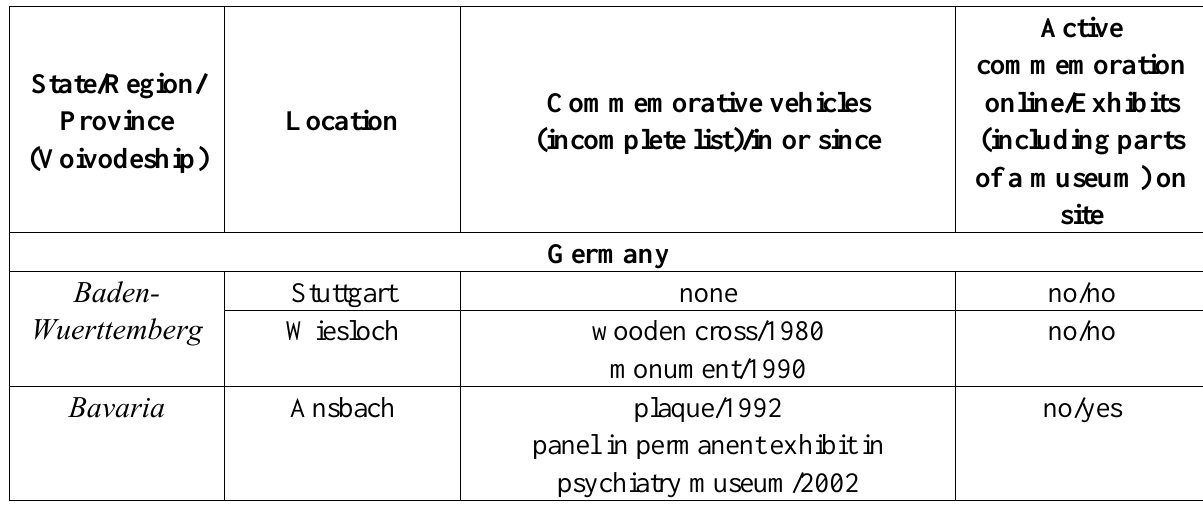
Table 1. Commemoration at approximate 30 sites of “Special Children’s Wards”